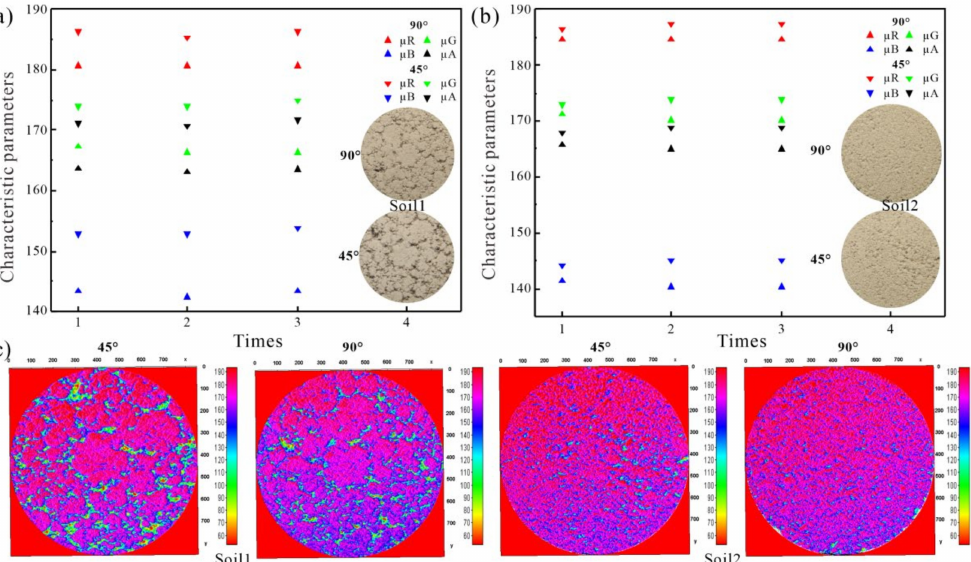
Figure 11. Characteristic parameters in RGB color space under different shooting angles: ( a ) and ( b ) characteristic parameters of Soil 1 and Soil 2 respectively derived from the RGB color space; ( c ) distribution of surface gray scale values.